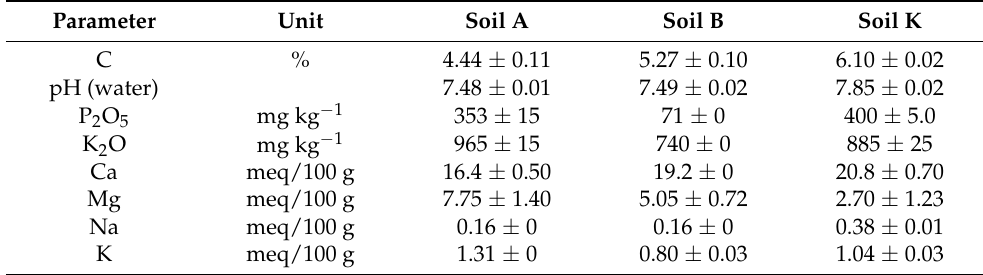
Table 1. Agrochemical profile of the research